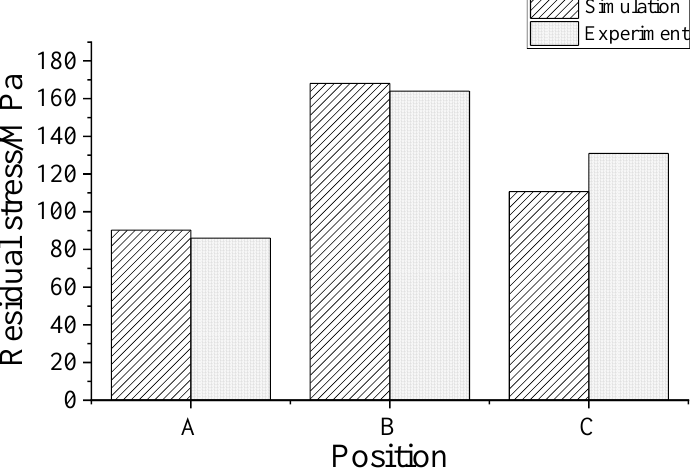
Figure 18. Residual stress at different positions.